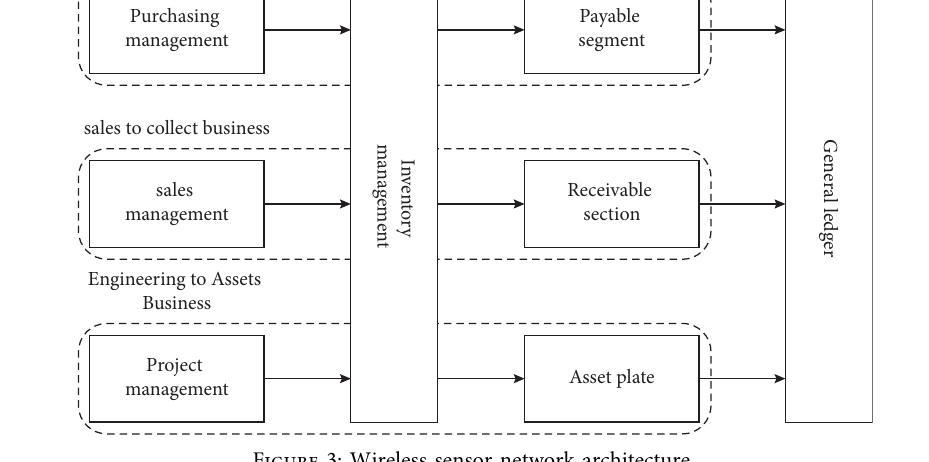
Figure 3: Wireless sensor network architecture.